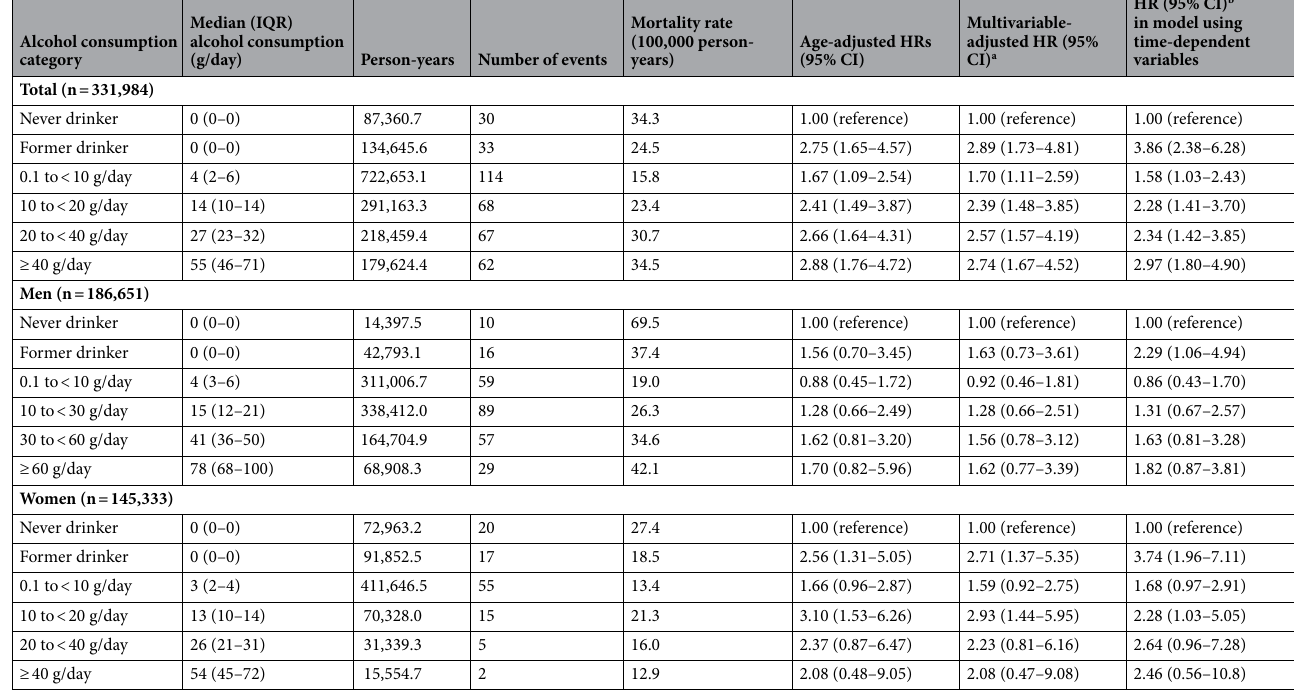
Table 2. Hazard ratios (95% CI) for cancer mortality by alcohol consumption category based on both lifetime abstinence history and current drinking status ( n = 331,984). P = 0.257 for the overall interaction between sex and alcohol consumption categories for cancer mortality (multivariable model). a Estimated from Cox proportional hazard models using age as a timescale to estimate hazard ratios (HRs) and 95 percent confidence intervals (95% CIs). Multivariable model was adjusted for age (timescale), sex (only for total subjects), center, year of screening exam, smoking status, total energy intake, physical activity, BMI, education level, history of diabetes, history of hypertension, history of cardiovascular disease, and family history of cancer. b Estimated from Cox proportional hazard models with alcohol consumption, smoking status, physical activity, total energy intake, and BMI as time-dependent categorical variables and baseline age, sex, center, year of screening exam, education level, history of diabetes, history of hypertension, history of cardiovascular disease, and family history of cancer as time-fixed variables. BMI body mass index, CI confidence interval, HR hazard ratio, IQR interquartile